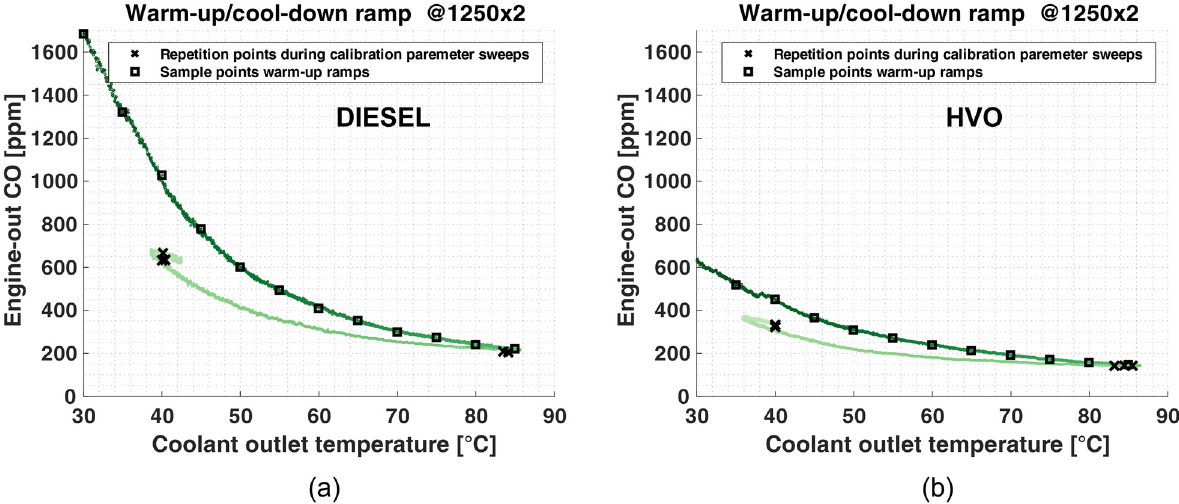
Figure 3. CO emissions for the 1250 × 2 ramp with diesel ( a ) and HVO ( b ) as a function of coolant outlet temperature. Dark and light green shades are the function of elapsed time (it is the same color palette as Figure 2). Black squared markers highlight data points used in the warm-up analysis in Section 3.1, whereas black cross markers highlight the results obtained by steady-state points ac-